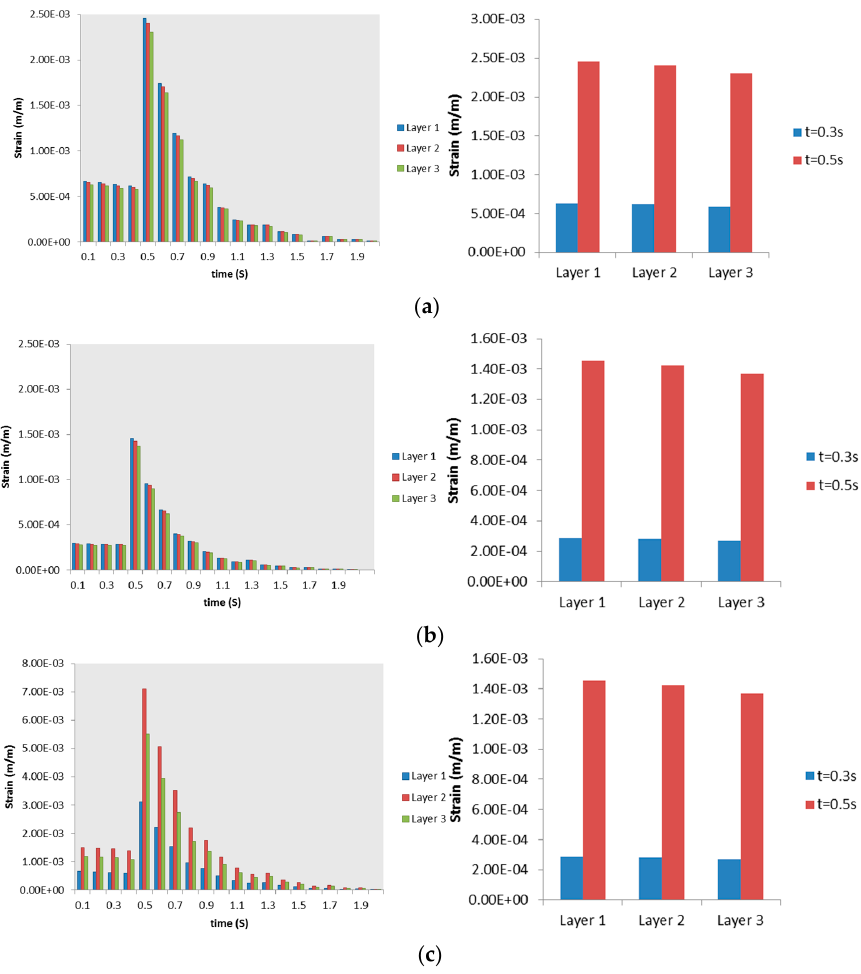
Figure 9. Maximum Von Mises strains occurring in ( a ) Section 1; ( b ) Section 2; and ( c ) Section 3. Right column shows strain progression over time, left column captures the Von Mises strain at specific time for a clearer comparison.